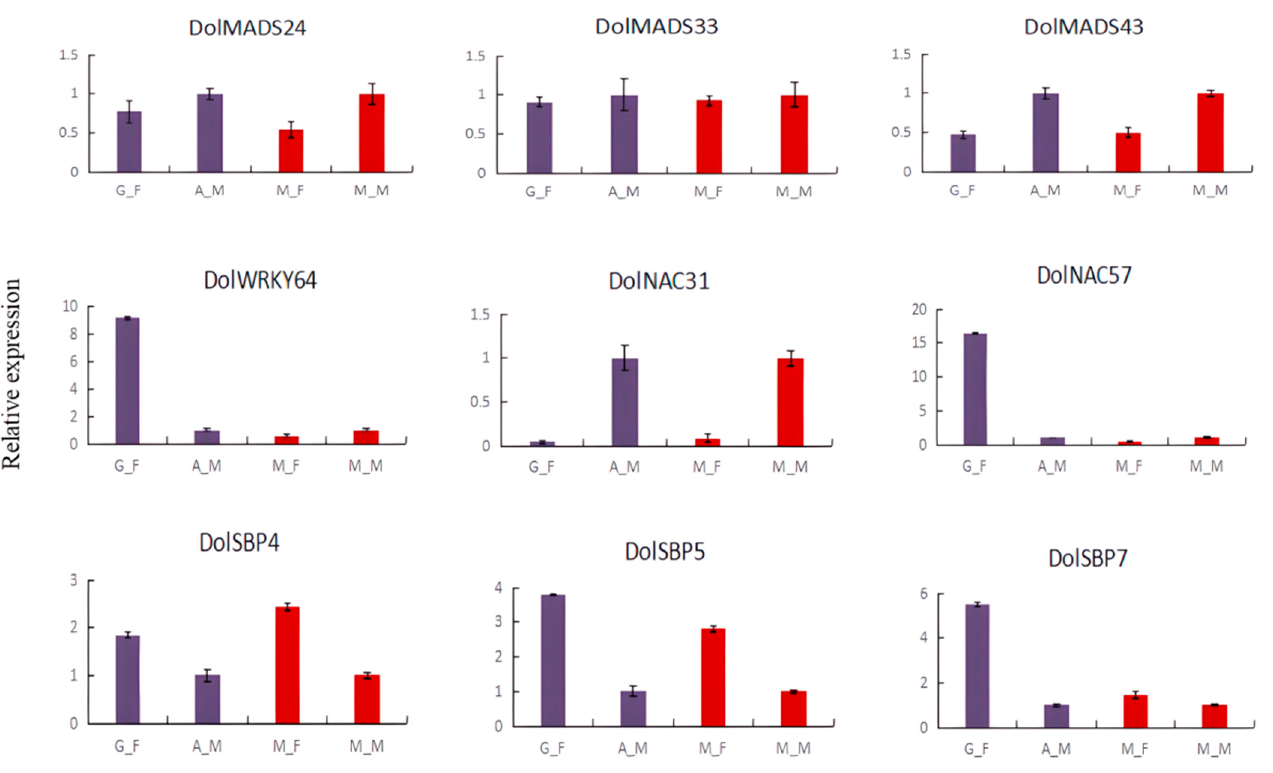
Figure 11. Expression analysis of three DolMADS s, one DolWRKY s, two DolNAC s, and three DolSBP s using RT-qPCR. Purple represents group 1 and red represents group 2. Bars indicate standard errors.